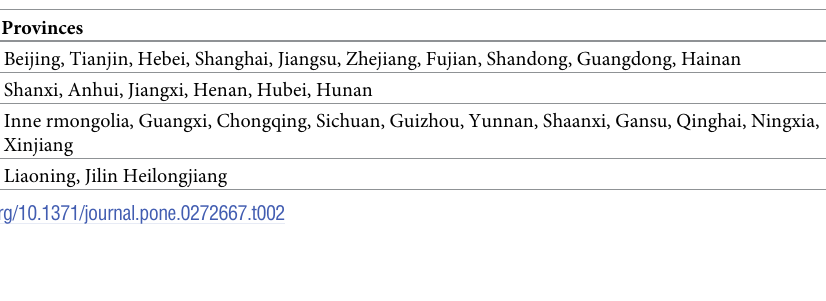
Table 2. East, West, Central and Northeast China